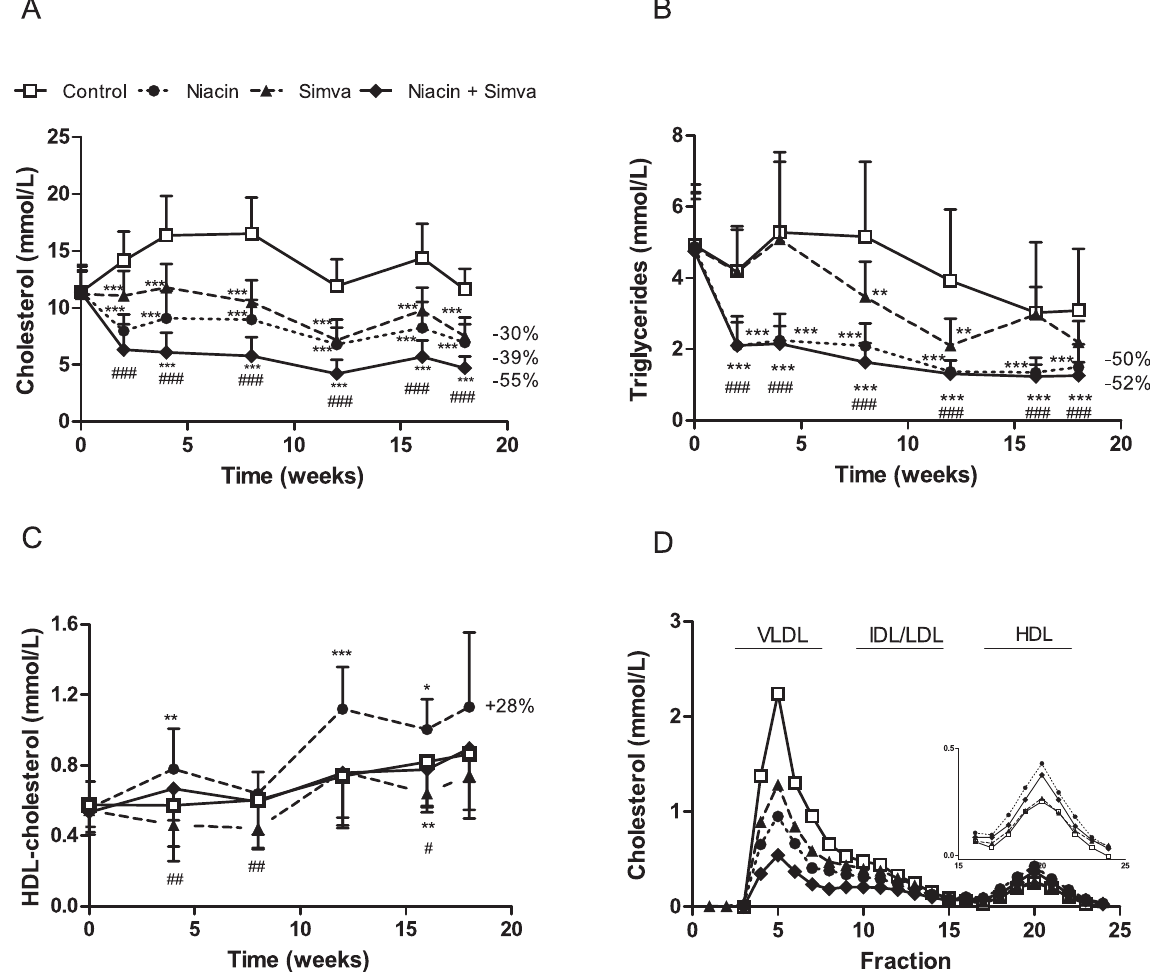
Figure 1. Effect of niacin, simvastatin and their combination on plasma lipid levels. Plasma total cholesterol (A), triglycerides (B) and HDL- cholesterol levels were measured at various time points throughout the study. The average HDL-cholesterol levels were calculated for all the treatment groups (C). Lipoproteins were separated by FPLC and cholesterol was measured in the fractions after 18 weeks of treatment (D). (Simva, simvastatin; values are means 6 SD; n=15 per group; **P , 0.01 and ***P , 0.001 as compared to control; # P , 0.05 and ### P , 0.001 as compared to niacin + simvastatin).